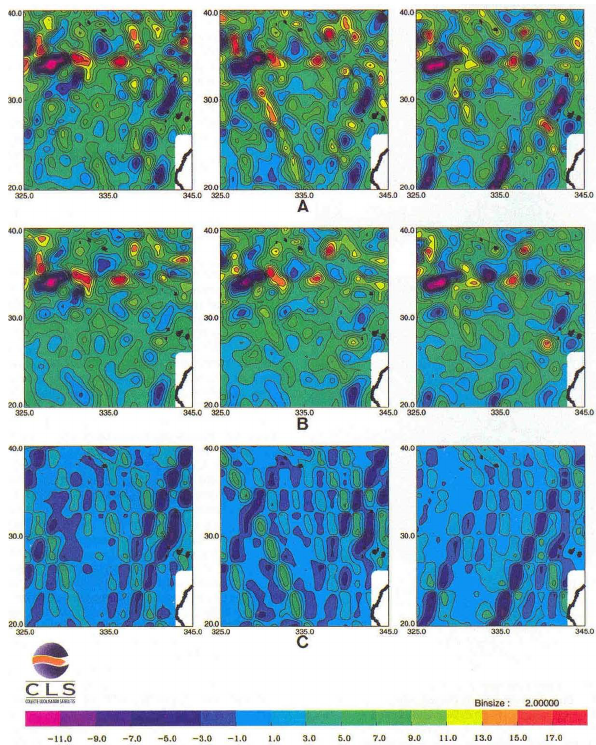
Fig. 6. Map of sea level anomaly derived from ERS-1 (right), T/P (middle) and T/P + ERS-1 (left) with a conventional mapping tech- nique (upper panel) and a mapping technique that takes into account long wavelength (correlated) errors (middle panel). Differences be- tween maps are shown in the lower panel. (from Le Traon et al., 1998). Units are